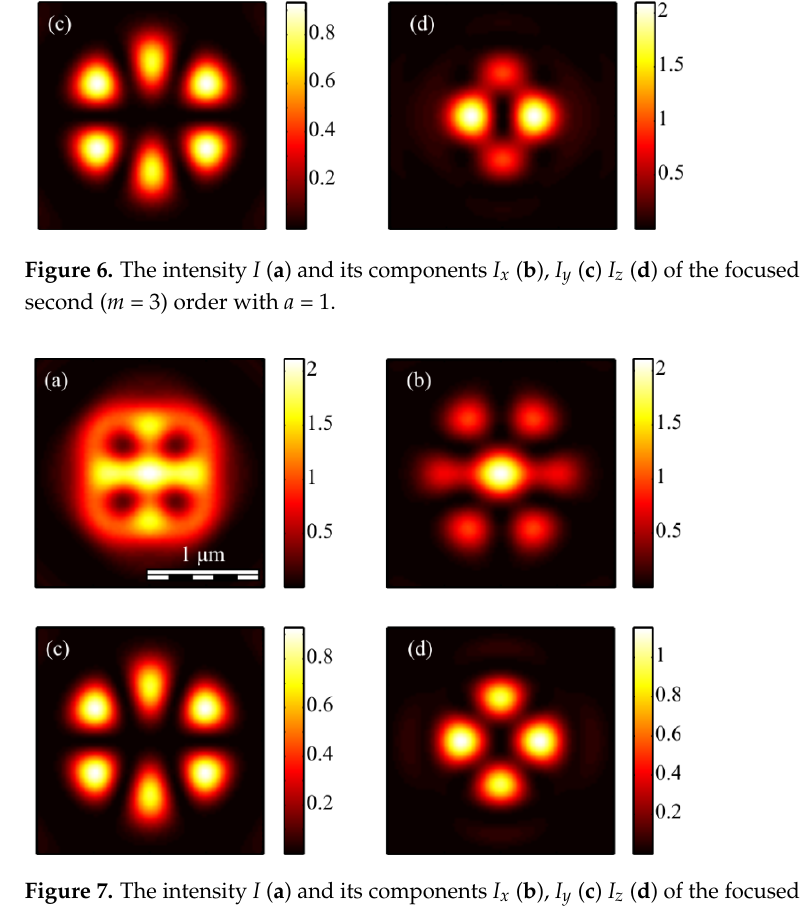
Figure 7. The intensity I ( a ) and its components I x ( b ), I y ( c ) I z ( d ) of the focused vector field (1) of the second ( m = 3) order with a = 1/2.